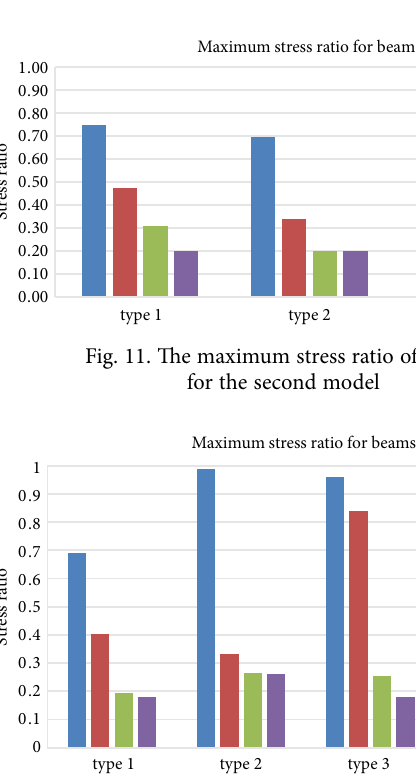
Fig. 10. Pareto-front of the second model